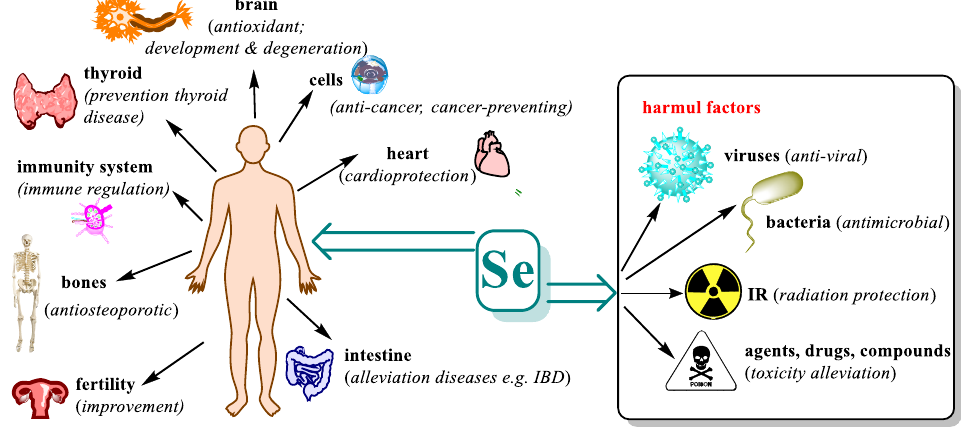
Figure 3. Effect of selenium on various organs and functions. (IBD, inflammatory bowel disease; based on references: [20,24,28 – 38]).